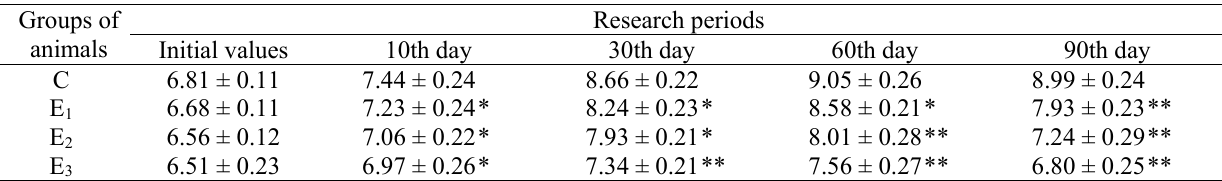
The effect of methionine, phenarone and methyphene on the content of diene conjugates in the serum of piglets in chronic nitrate-nitrite toxicosis, μmol/l (М±m, n = 5) Groups of